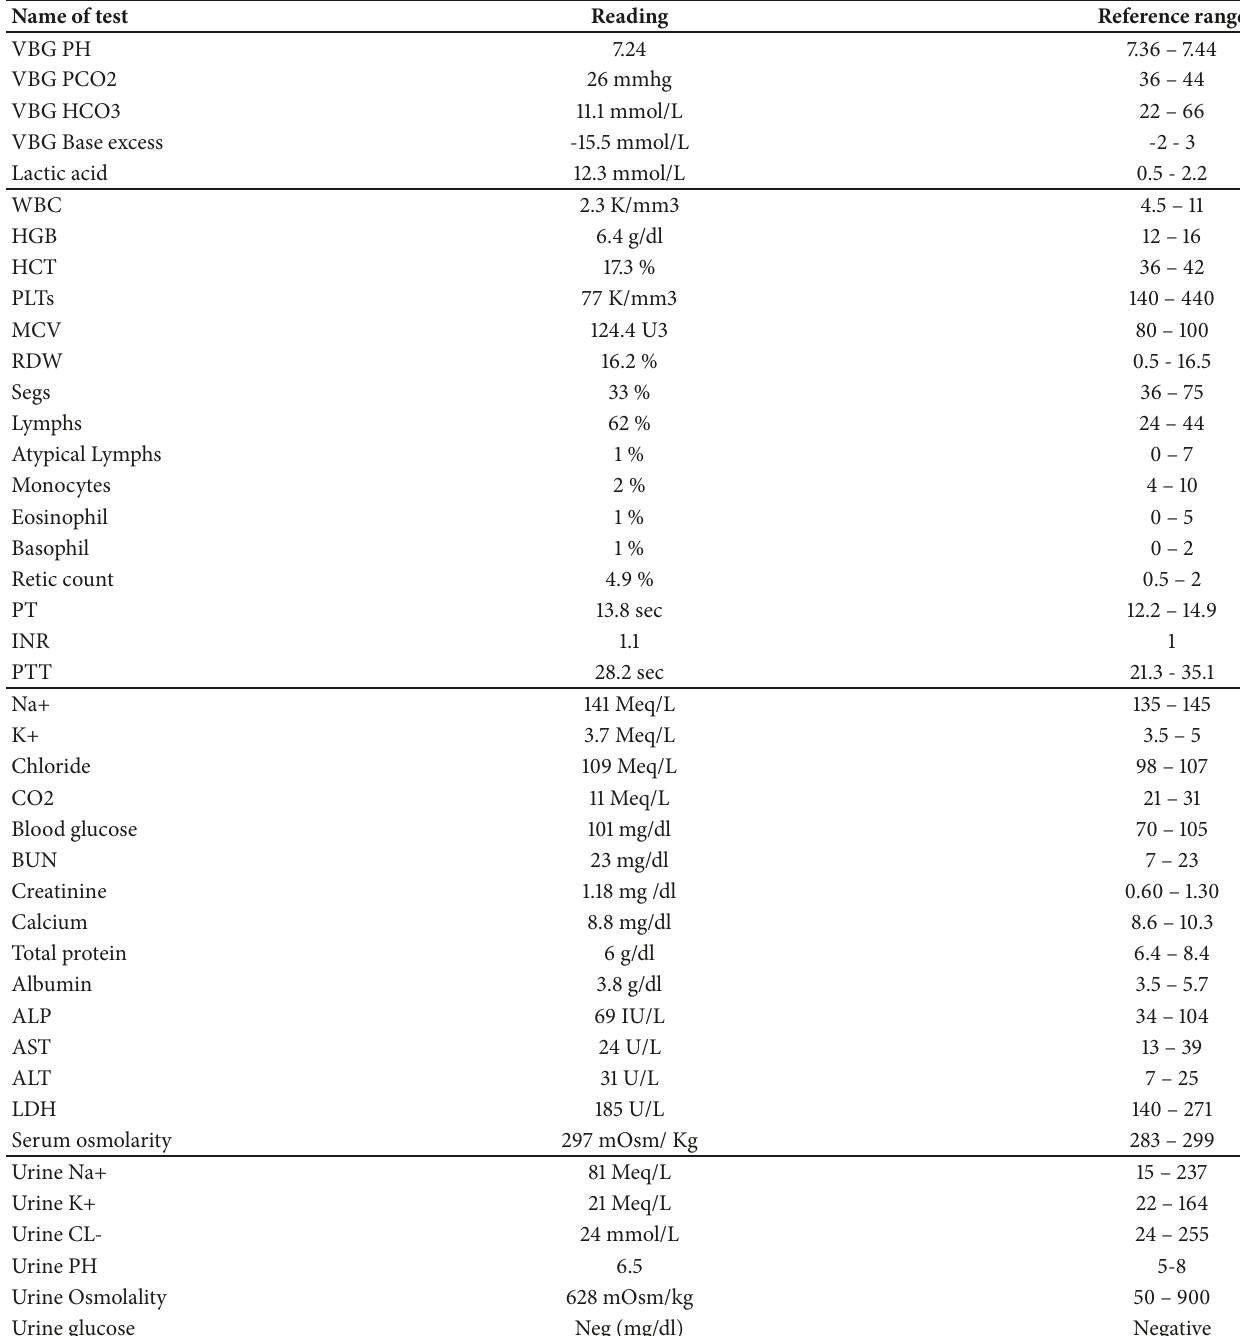
Table 1: Initial blood work